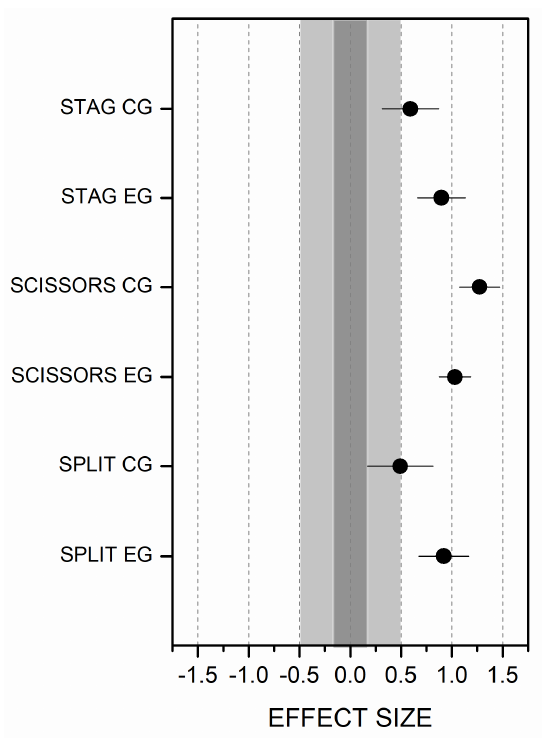
Figure 5. Standardized effect size of differences between pre and post-test RG leap scores.